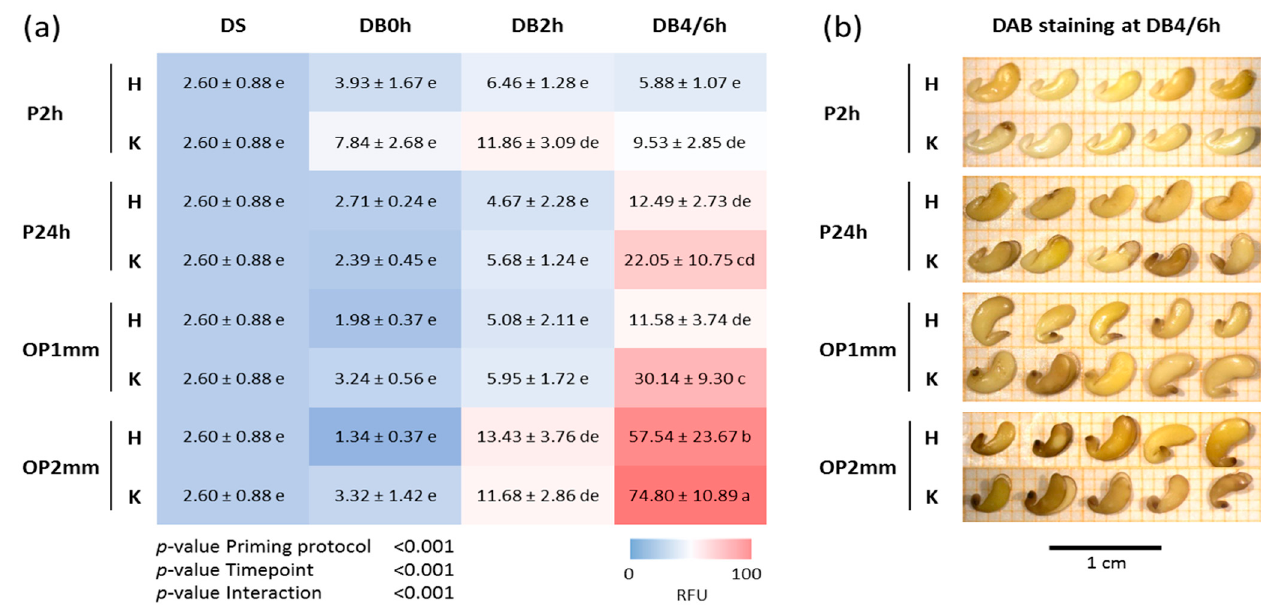
Figure 5. Accumulation and distribution of ROS in M. truncatula seeds during post-priming dehydration. ( a ) ROS levels in dry seeds and during dry-back (at 0, 2 and 4/6 h) assessed through DCF-DA assay. Mean values of relative fluorescence units (RFU) ± standard deviation are shown. p -values are also provided referring to the differences between priming protocols, timepoints of dry-back, and their interaction, as analyzed with two-way ANOVA and Tukey test. Within the dataset, values that are followed by common letters are not significantly different ( p -value < 0.05). ( b ) Distribution of H 2 O 2 within embryos assessed through DAB staining at the endpoint of dry-back (4/6 h). DS, dry seed; P2h, 2 h-priming; P24h, 24 h-priming; OP1mm, hydroprimed seeds with 1 mm radicle protrusion; OP2mm, hydroprimed seeds with 2 mm radicle protrusion; H, hydropriming protocols; K, hormopriming protocols; DB2h, ROS levels after 2 h dry-back; DB4/6h, ROS levels at the endpoint of dry-back; RFU, relative fluorescence units.